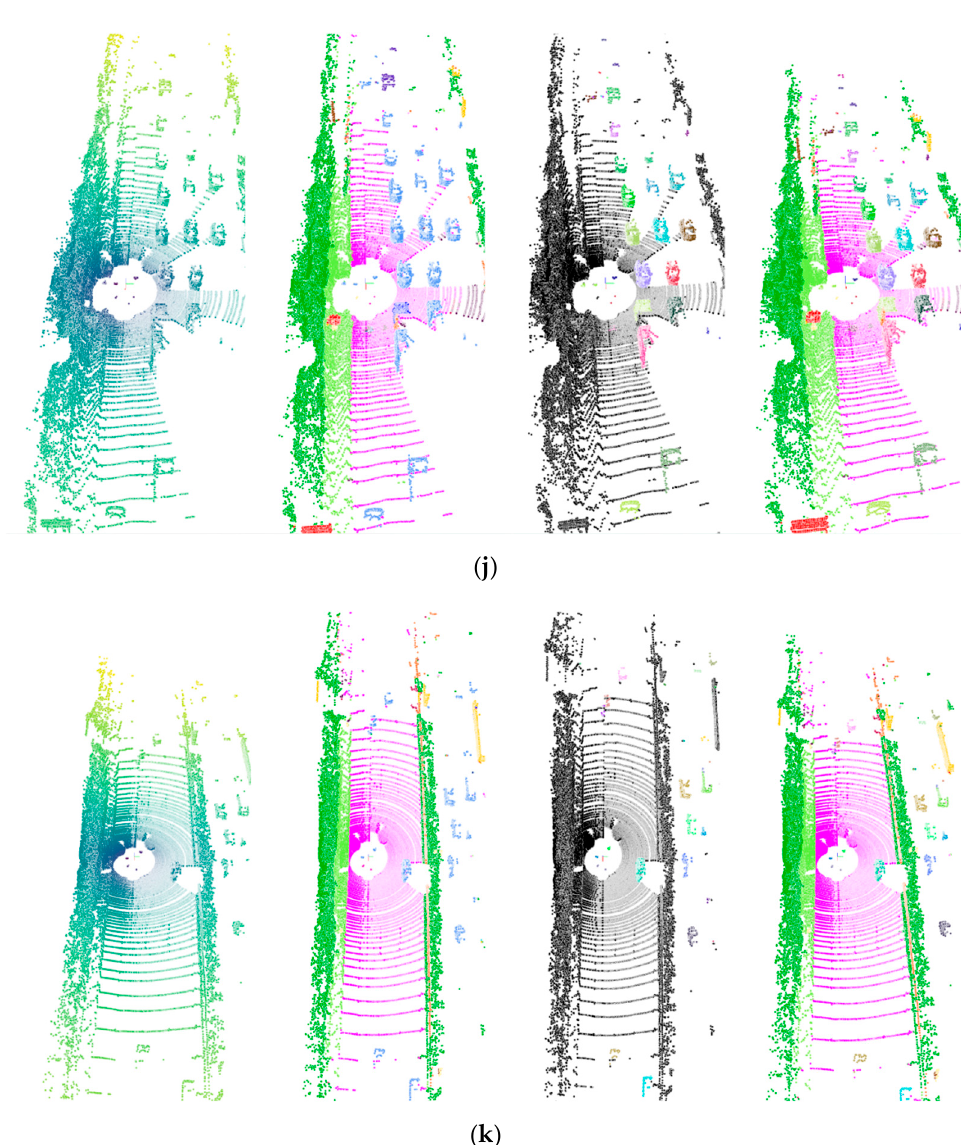
Figure 9. Visualization of our approach on the test split of SemanticKITTI—sequence 11–21. From left to right: raw scan, semantic prediction, instance prediction, panoptic prediction. The colors of the stuff classes are consistent with the legends shown in Figure 1e, and the color of each instance of the thing classes in each subfigure is given randomly. ( a ) Sequence 11. ( b ) Sequence 12. ( c ) Sequence 13. ( d ) Sequence 14. ( e ) Sequence 15. ( f ) Sequence 16. ( g ) Sequence 17. ( h ) Sequence 18. ( i ) Sequence 19. ( j ) Sequence 20. ( k ) Sequence 21.